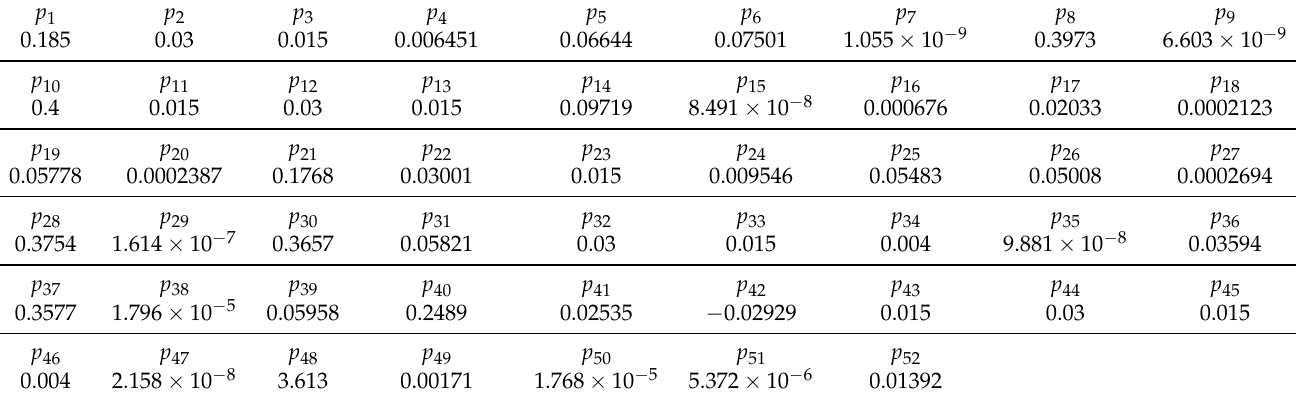
Table 4. Design variable vector p obtained from the robust balancing design (RBD) approach.